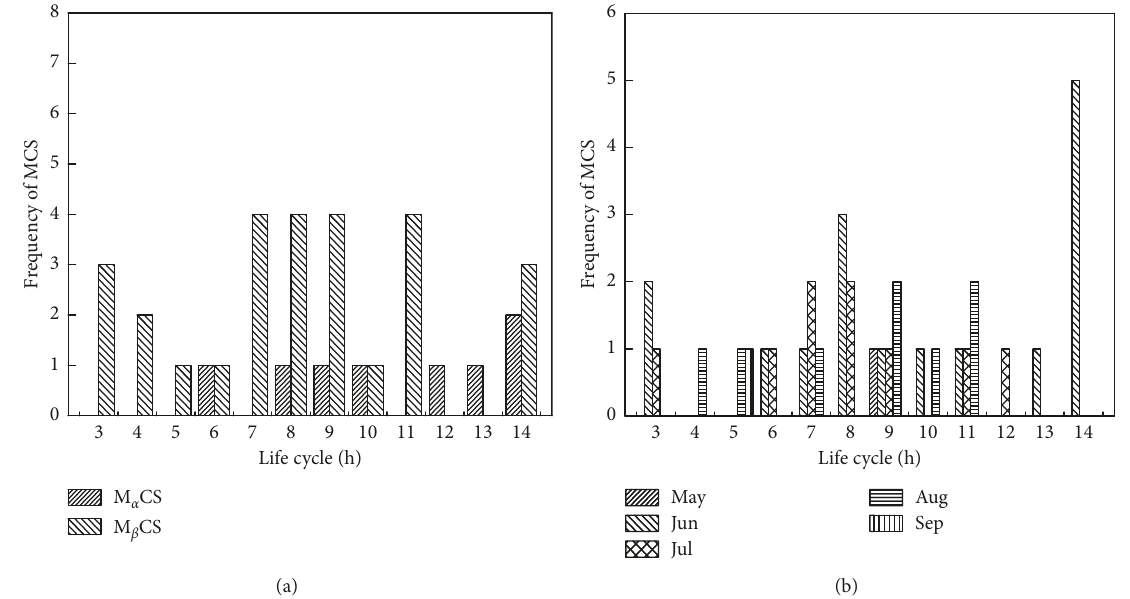
Figure 6: The lifespan distribution of MCSs (a) at different scales and (b) in different